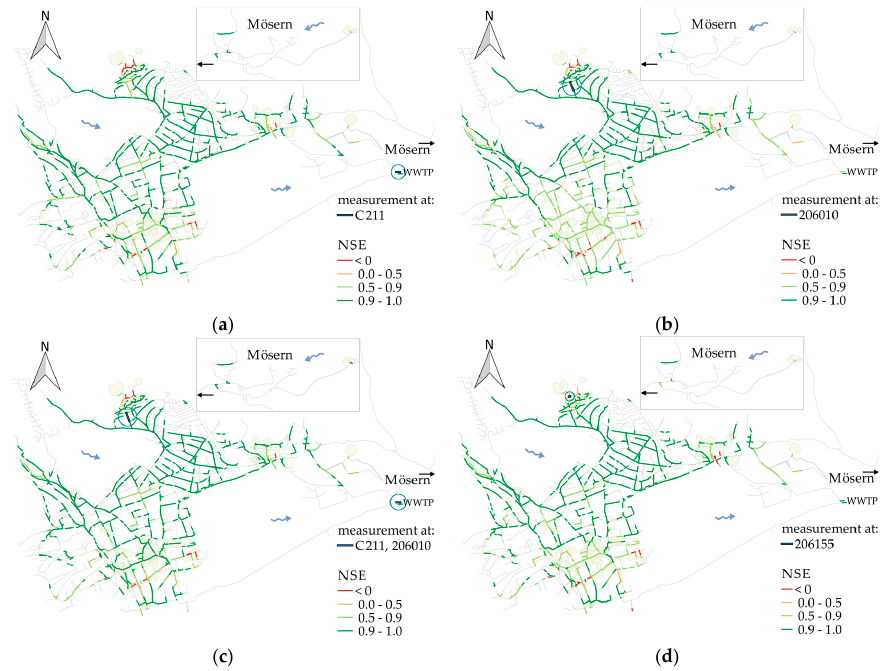
Figure 5. Example for the process of finding suitable combinations of measurements ( a – d ) exemplify results of the intermediate steps; Comparisons to the reference model are only evaluated for previously defined potential measurement stations, therefore all other pipes are depicted as a thin grey lines; encircled pipes are the measurement points).